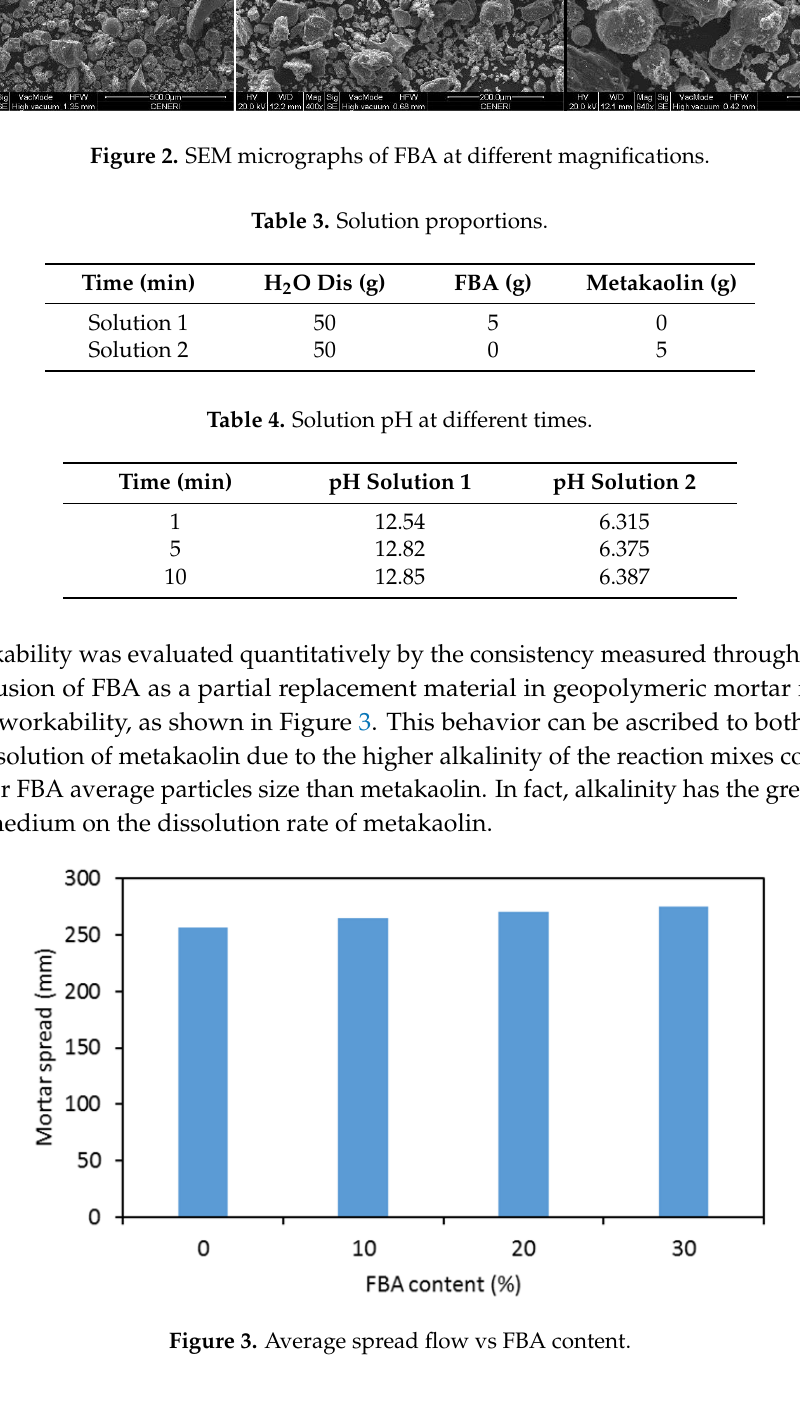
Figure 3. Average spread flow vs FBA content.